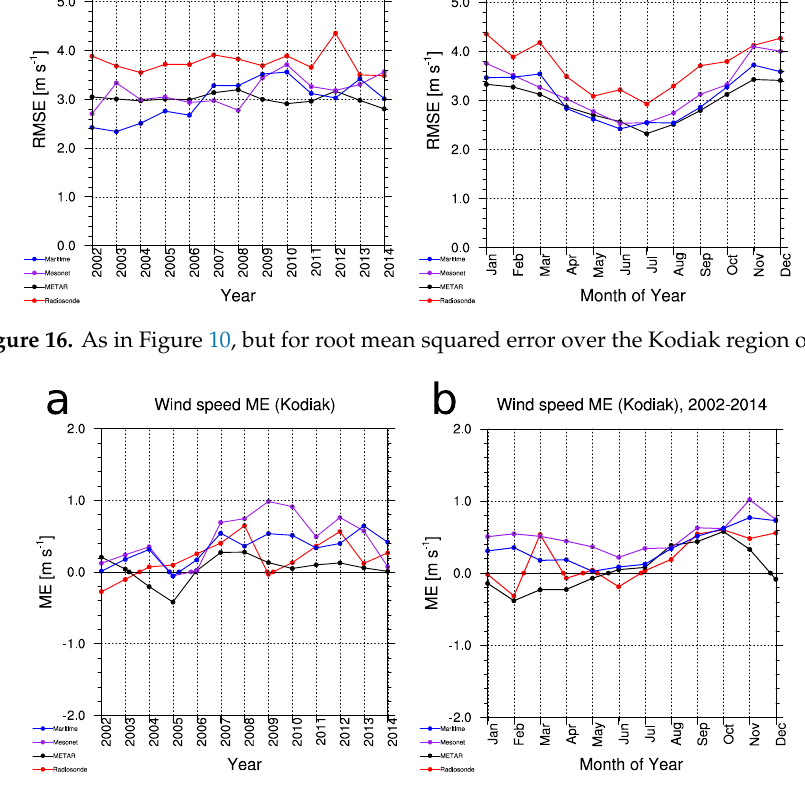
Figure 17. As in Figure 10, but for the mean error (bias) over the Kodiak region only.